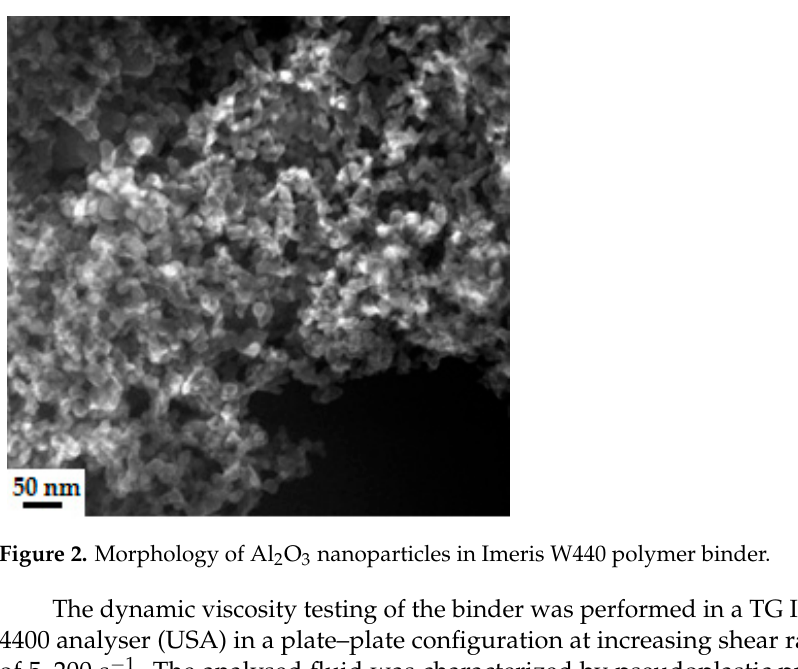
Figure 1. Dynamic viscosity versus shear rate (black curve) and shear stress versus shear rate (red curve) of Imerys W440 binder.